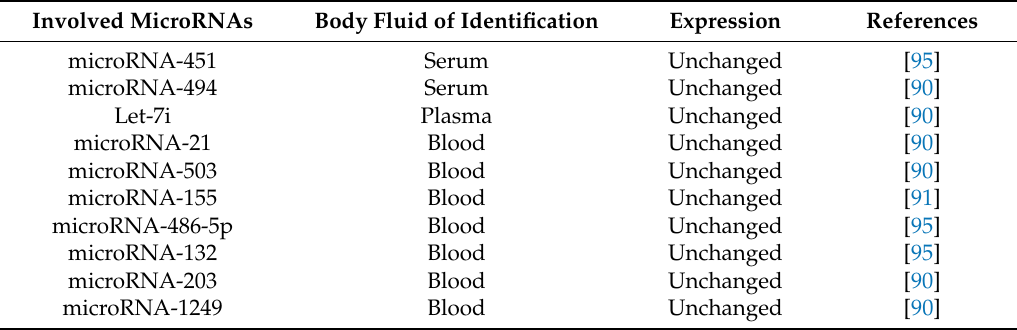
Table 2. MicroRNA expression unchanged in